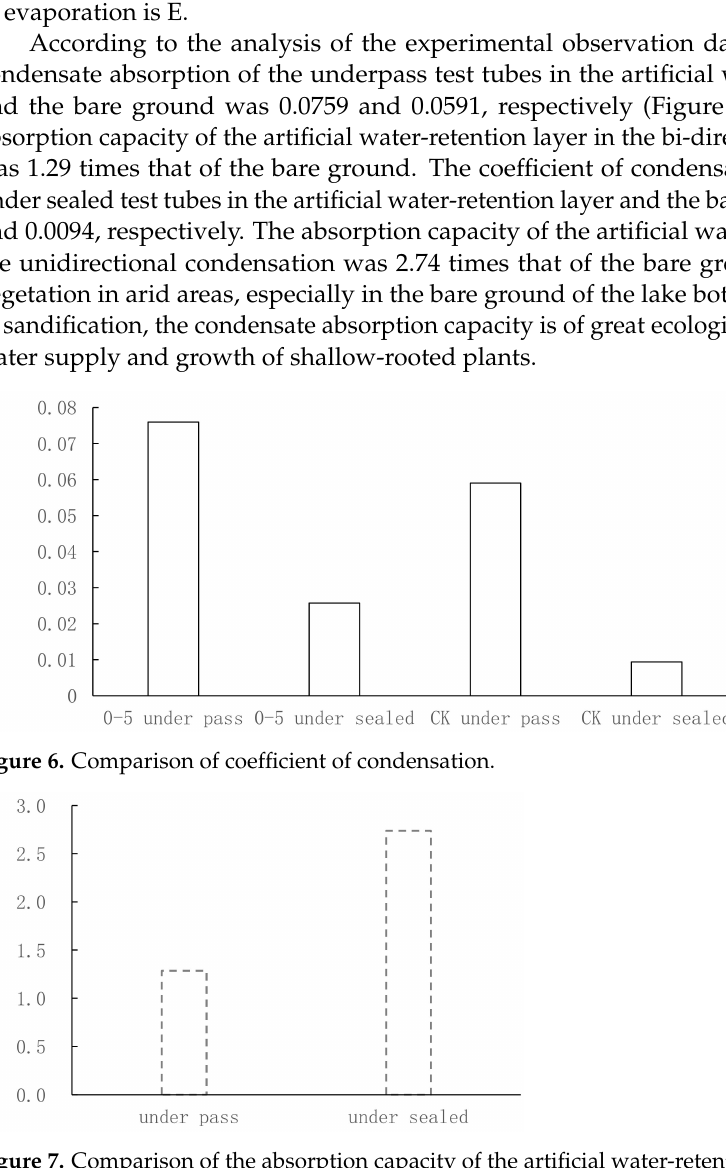
Figure 7. Comparison of the absorption capacity of the artificial water-retention